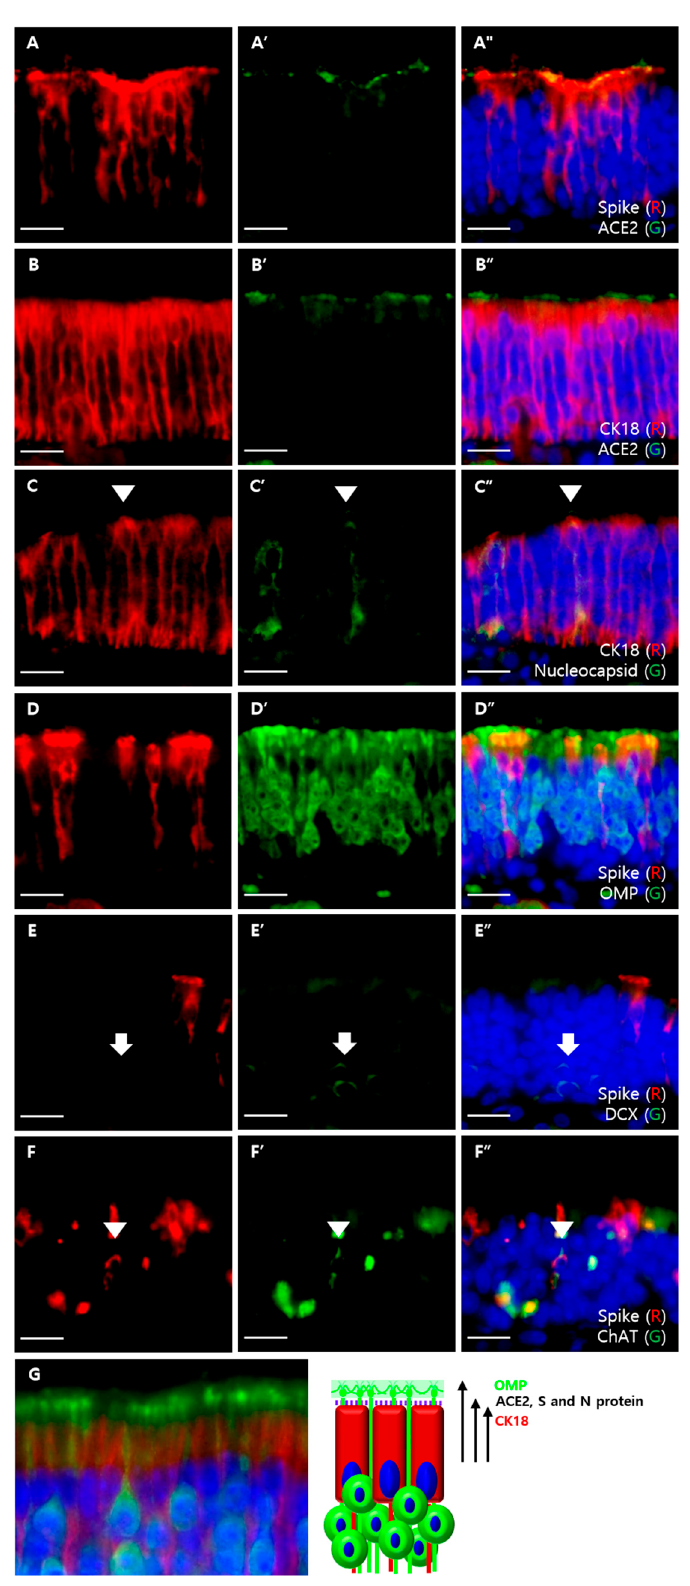
Figure 3. Double immunofluorescent labeling of MOE. All sections were counterstained with DAPI (blue). Scale bars = 20 μ m. ( A ) Colocalization of the S protein (red) and ACE2 (green). The apical portion of the S protein and ACE2 had similar levels; ( B ) colocalization of CK18 (red) and ACE2 (green). The apical portions of CK18-positive cells were located lower than the levels of ACE2 ex- pression; ( C ) colocalization of CK18 (red) and N proteins (green). Some CK18-positive cells were colocalized with the N protein (arrowhead); ( D ) colocalization of the S protein (red) and OMP